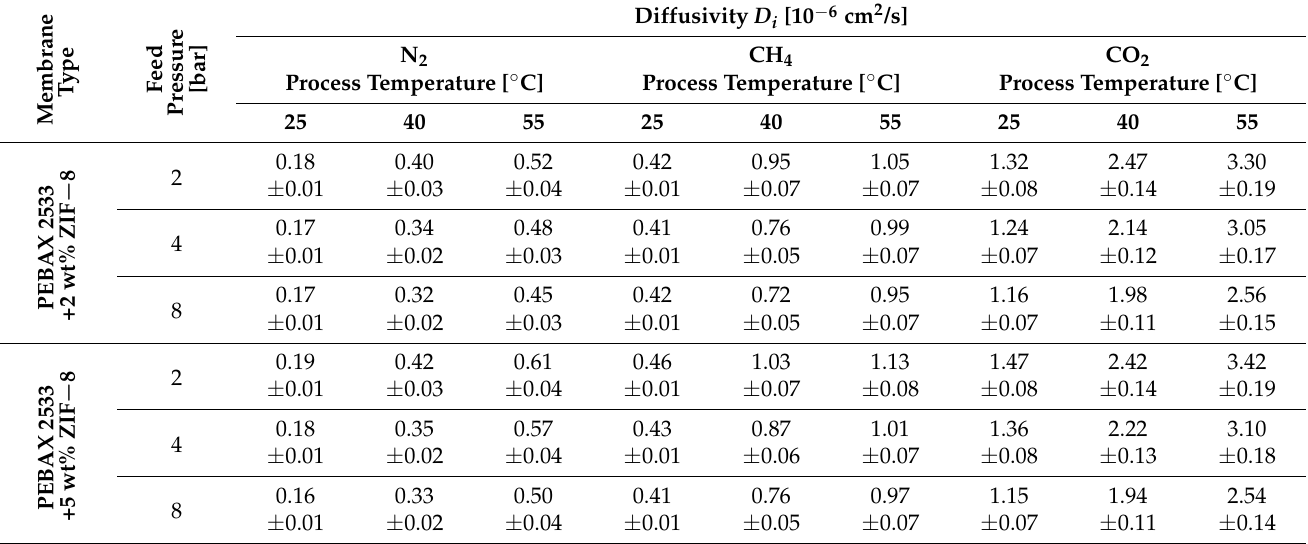
Table A7. Diffusion coefficient of heterogeneous membranes containing ZIF − 8 to different gases measured for different feed pressure and temperature